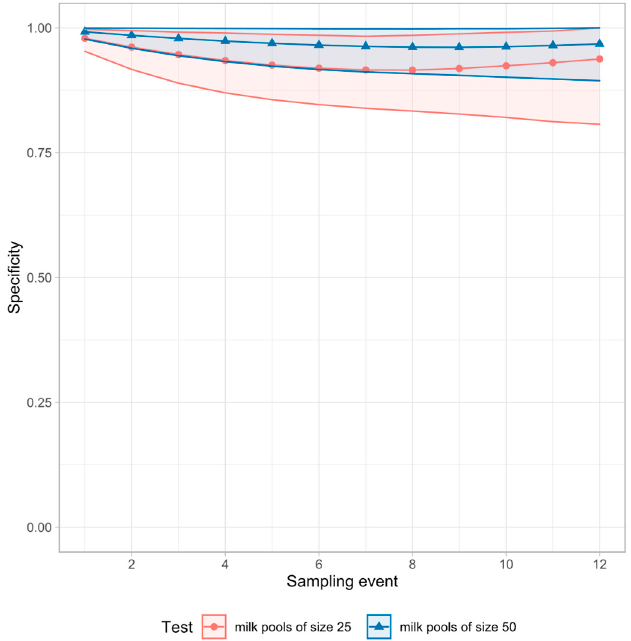
Figure 4. Cumulative specificity and 95% CI of pooled milk samples for the detection of antibodies against MAP. Model run with the data of all herds.